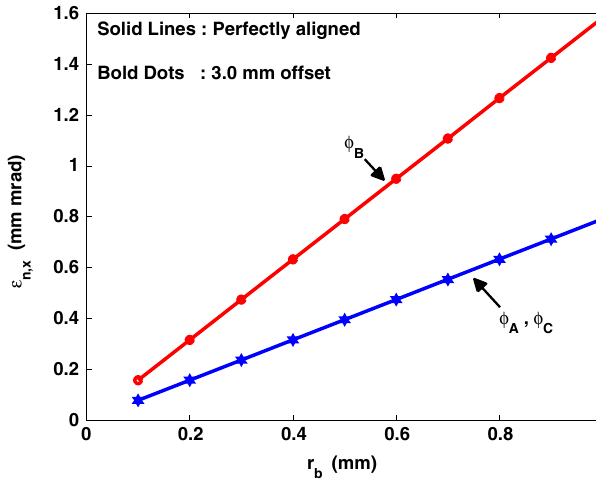
FIG. 19. Vertical projected emittance of beam for different bunch radius. Solid lines correspond to perfect alignment and the bold dots are the representative of ‘‘3 mm’’ misalignment.